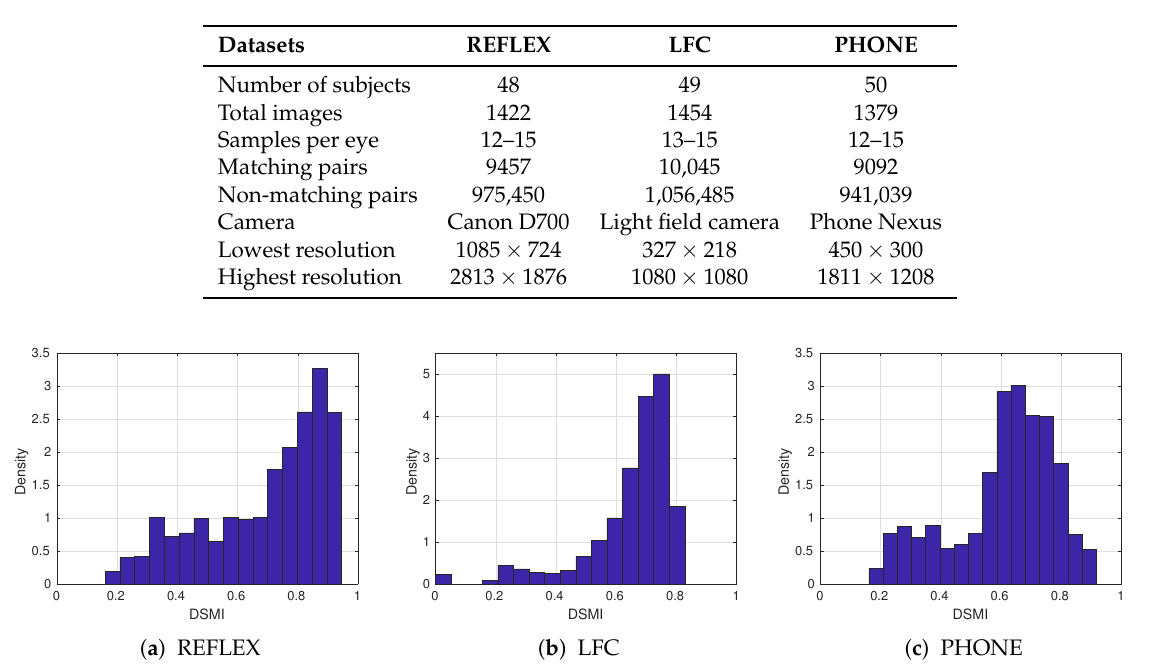
Figure 5. Normalized histograms of the quality scores according to the DSMI metric on three test iris